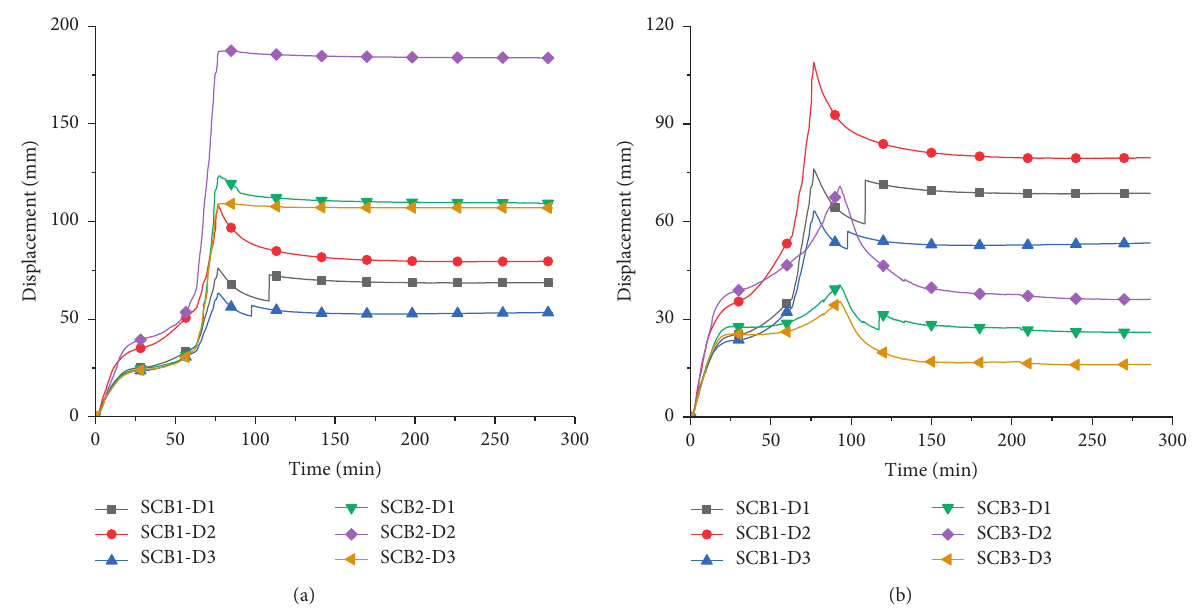
Figure 11: Comparisons of displacement developments of (a) SCB-1 and SCB-2 and (b) SCB-1 and